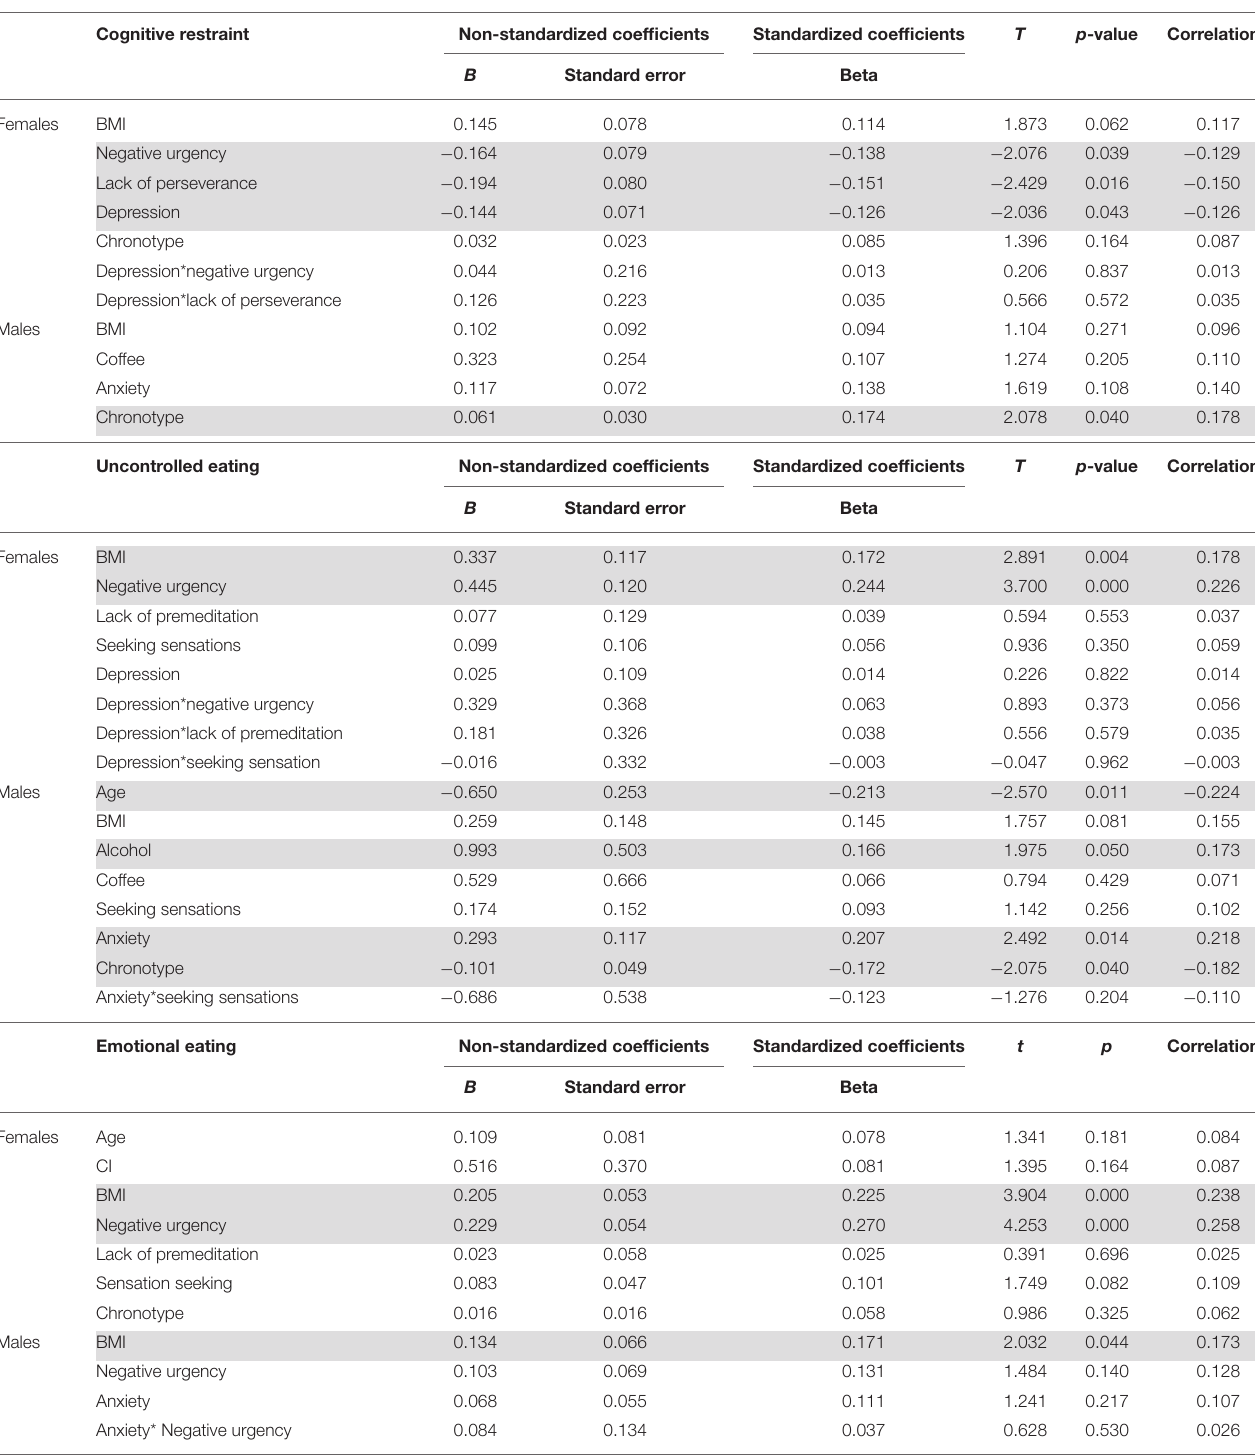
TABLE 8 | Multivariate analysis: factors significantly correlated to the three domains of the eating habits questionnaire. Cognitive